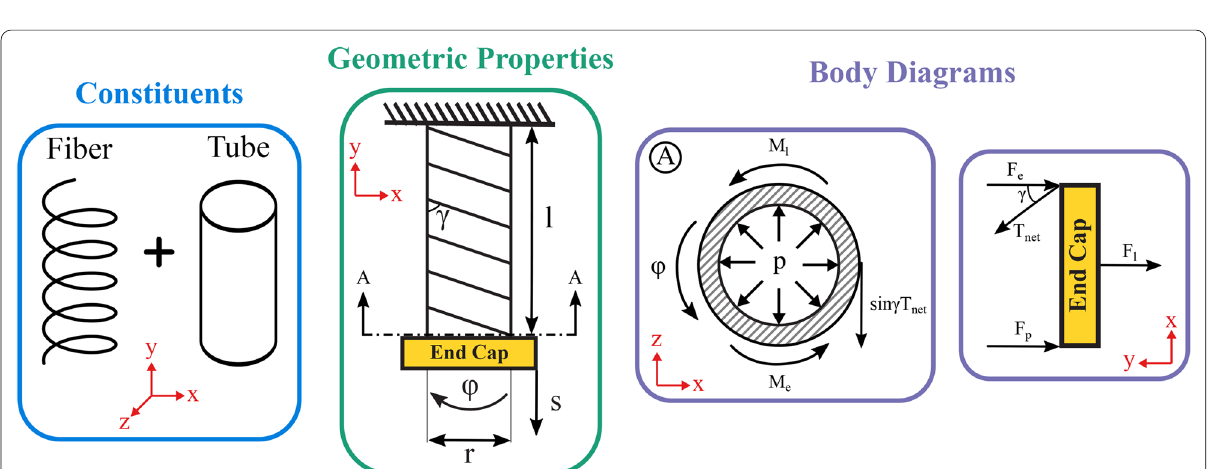
Fig. 3 Schematic views of a Fiber-Reinforced Elastomeric Enclosure. We model the force contributions of fibers as a single fiber to facilitate the derivation of the lumped-parameter model (Constituents). Elongation s and rotation φ are the two degrees of freedom of the FREE. FREE’s Geometric Properties are variable and pneumatic pressure produces reaction forces and moments at the end cap (Free Body Diagrams). Note that the fiber itself is not depicted in the Free Body